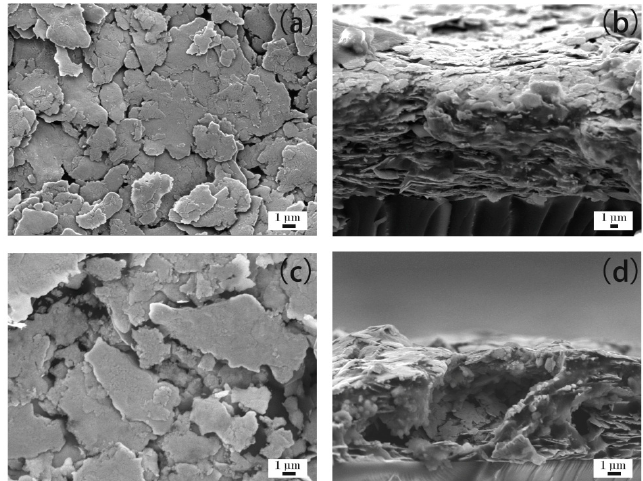
Figure 7. ECAs filled with 50 wt % Ag flakes. ( a ) ECAs fabricated by the powder spraying process; and ( b ) cross sections of ECAs fabricated by the powder spraying process; ( c ) ECAs fabricated by the conventional process; and ( d ) cross sections of ECAs fabricated by the conventional process.